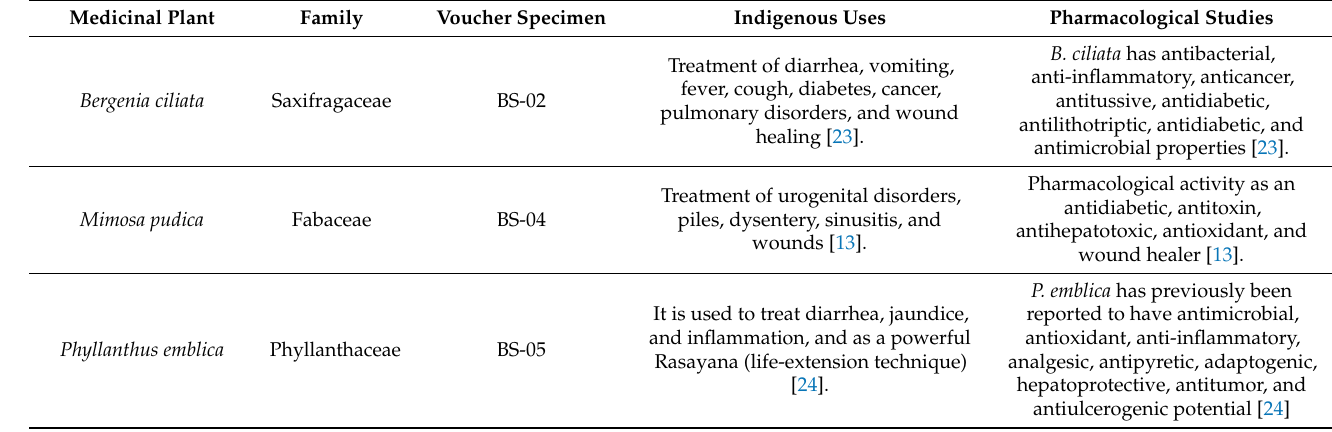
Table 1. List of selected medicinal plants for the study with their reported traditional